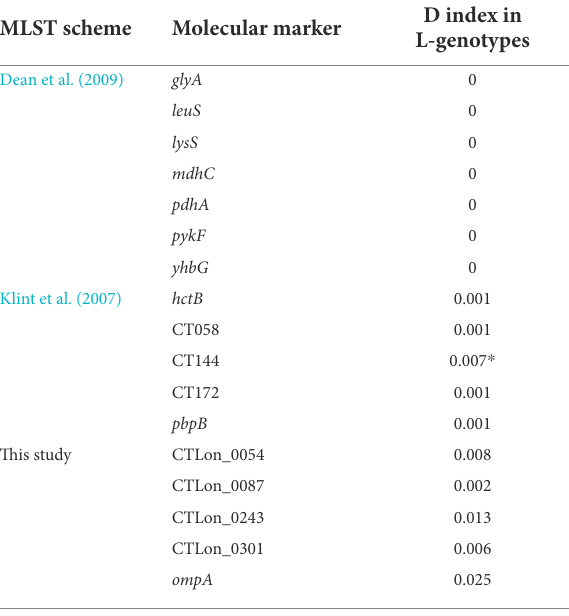
TABLE 2 Mean evolutionary diversity (D index) for each marker of the previous MLST schemes and the one proposed in this study. MLST scheme Molecular